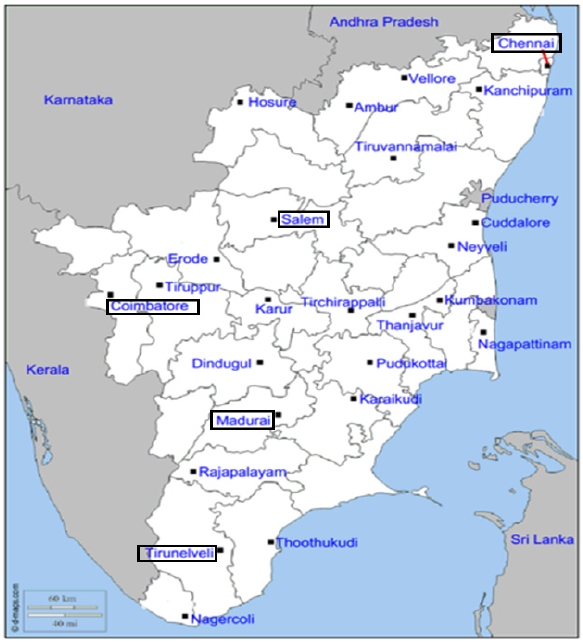
Figure 1. Map of Tamil Nadu showing the chosen five cities (marked with